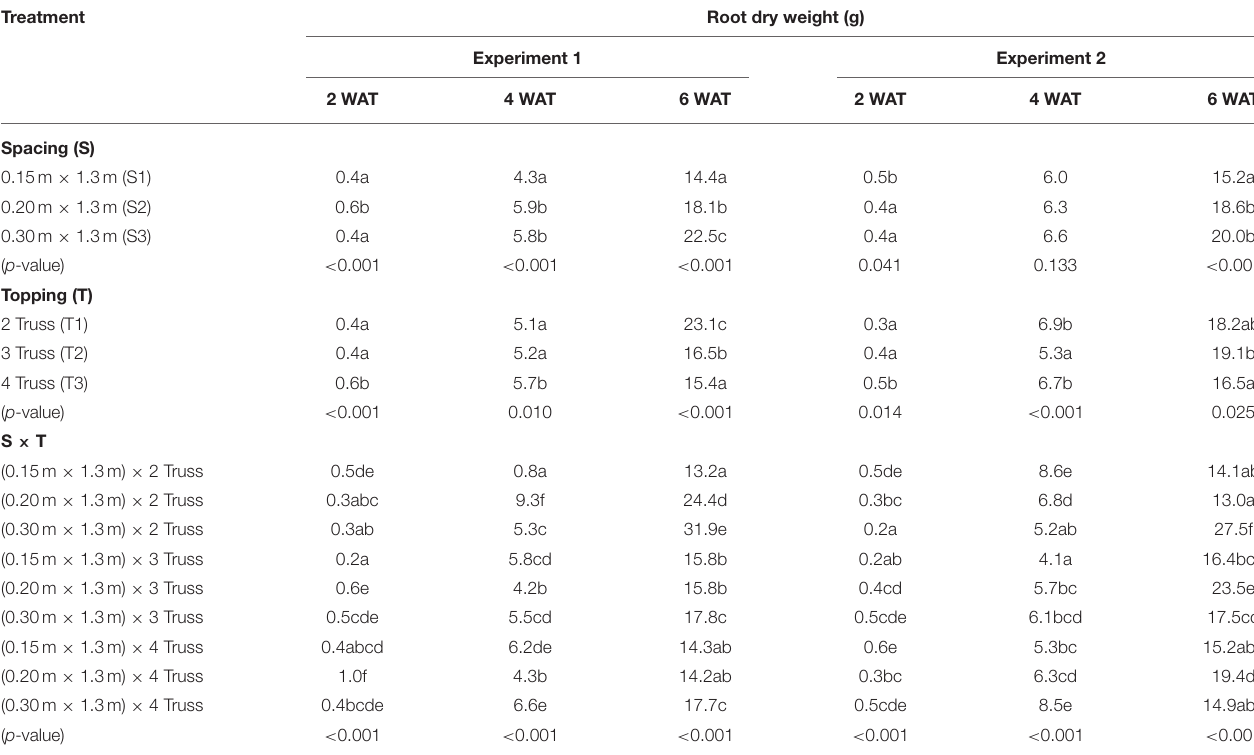
TABLE 5 | Effect of spacing and topping on plant root dry weight of Solanum lycopersicum under greenhouse conditions.